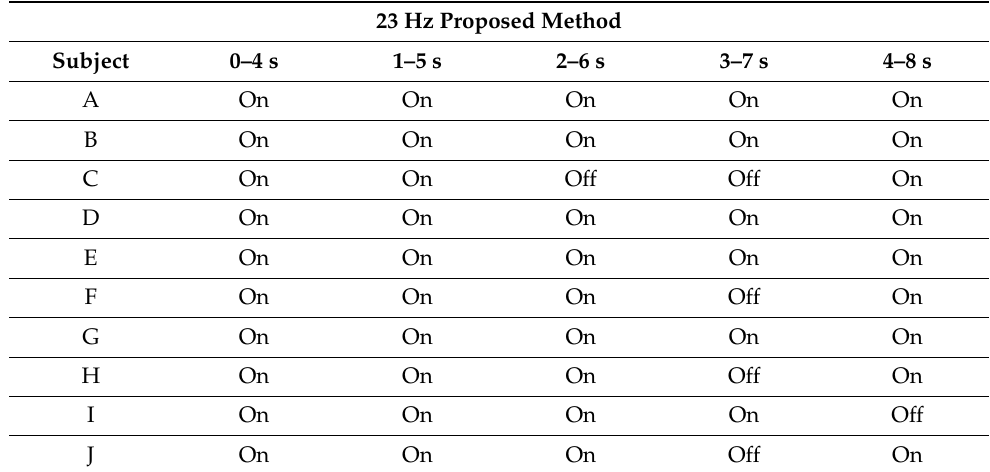
Table 3. The proposed method has five signals in the 23 Hz brainwave signal.